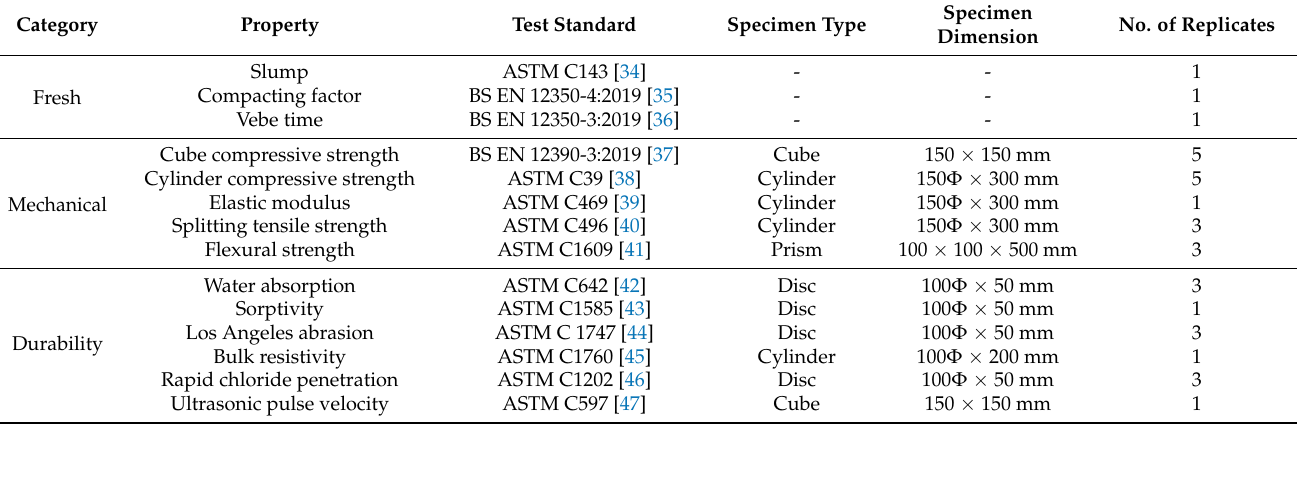
Table 5. Testing methods and specimen details.